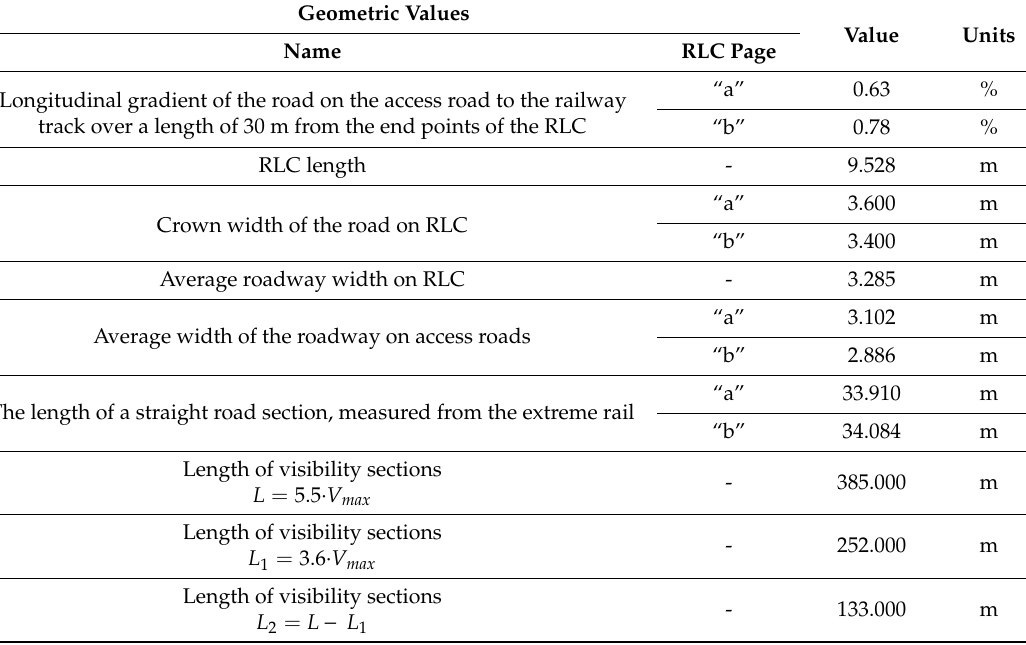
Table 5. Geometric linear values of the triangles of visibility of the studied RLC: 144 007 581. Geometric Values